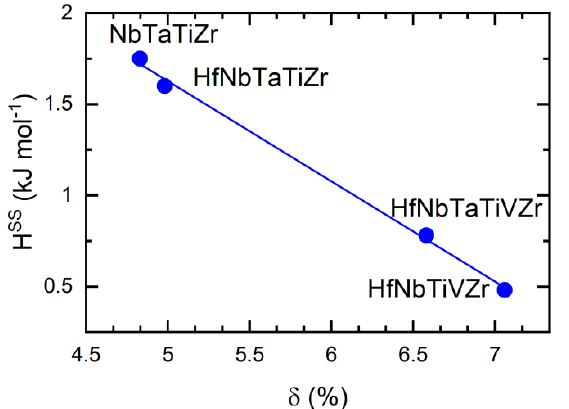
Figure 1. Correlation plot of the mixing enthalpy of solid solution H SS and the atomic misfit parameter δ .